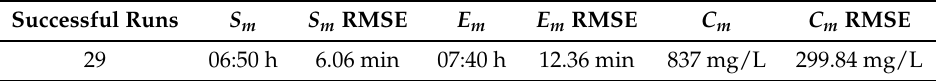
Table 4. Contamination event RMSE analysis for Richmond network of all 30 runs.